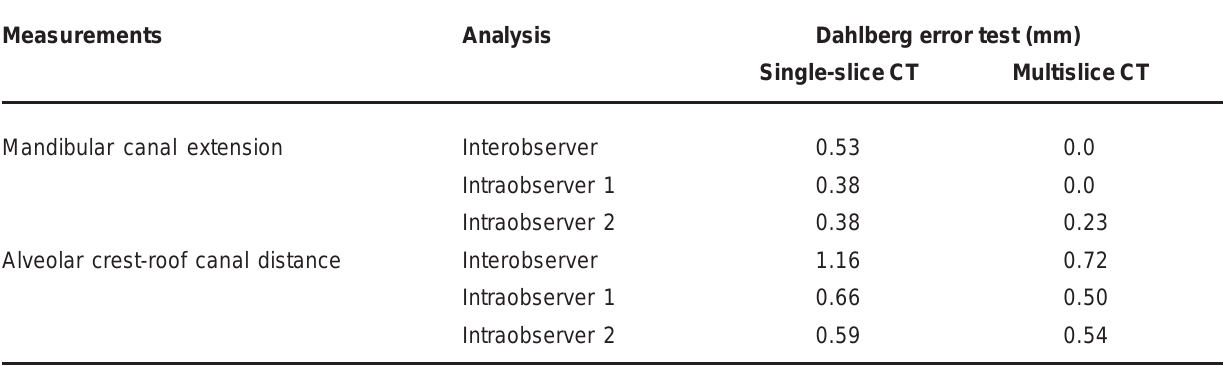
TABLE 1- Intra and interobserver mean errors (Dahlberg Error) in single-slice and multislice CT